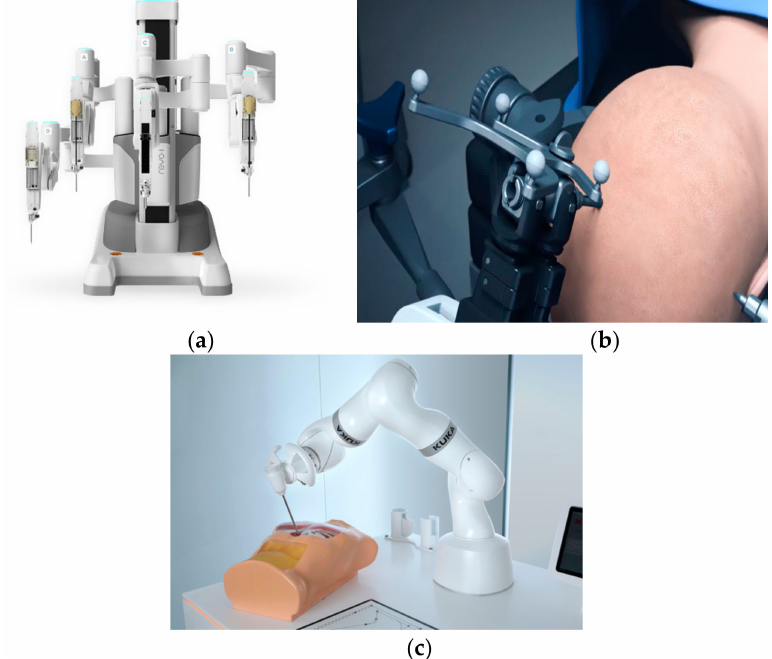
Figure 13. Specialized robots for general, spine and cranial biopsy and surgery. ( a ) Revo-i surgical robot [62]. ( b ) STEALTH AUTOGUIDE: Cranial Robotic Guidance Platform [63]. ( c ) KUKA LBR Med surgical robot